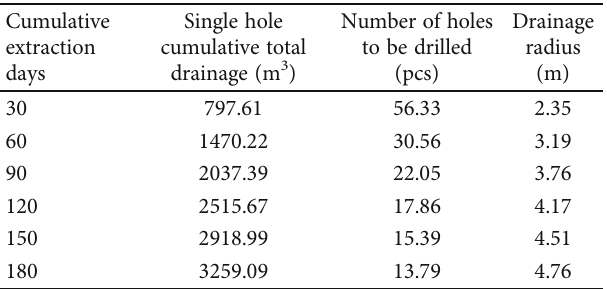
Table 2: Calculation results of the extraction radius of the slotted hole ( fi tting the negative exponential curve of extraction